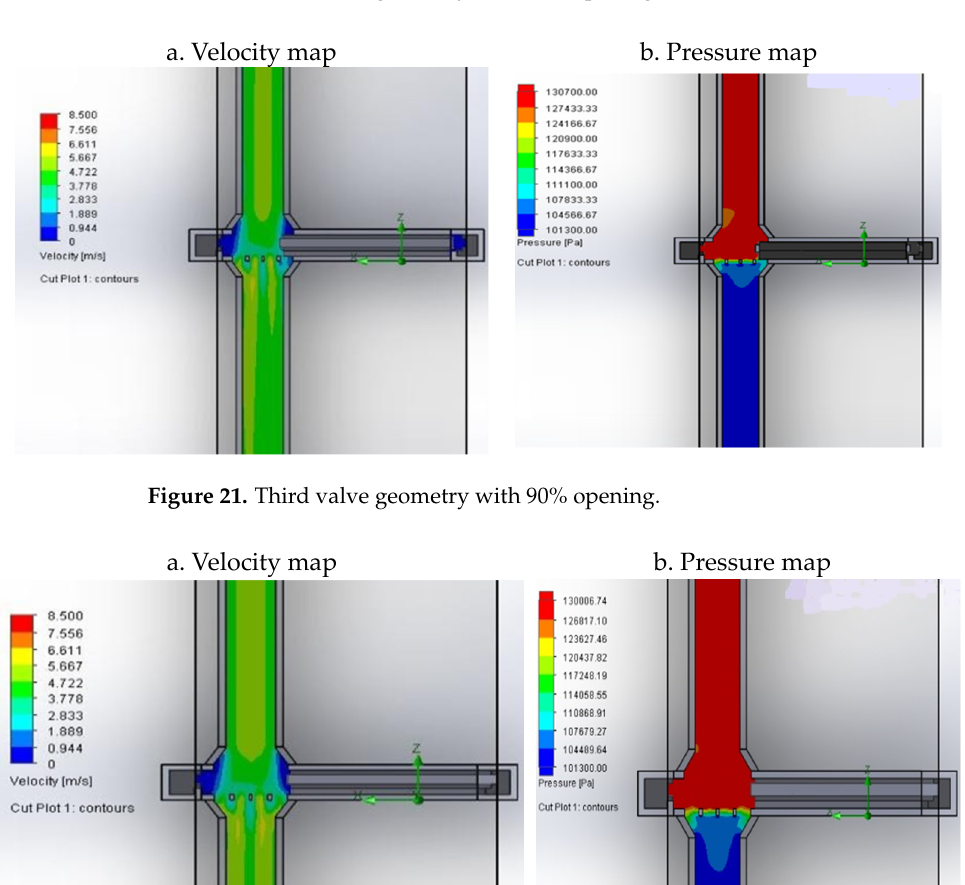
( c ) Figure 23. Changes in valve geometry. ( a ) First valve geometry; ( b ) second valve geometry; ( c ) third valve geometry. For the third geometry, the head loss was determined based on the results obtained from the fl ow simulation with the CFD software. Using Equation (7), a 2.90 pressure drop coe ffi cient of the valve when 100% open (Kv 100 ) was calculated. In comparison, the head loss coe ffi cient for a globe valve when 100% open is Kv 100 = 9.00 [33]. This indicates that the new valve possesses a great advantage over the globe valve when comparing their head loss coe ffi cients (Kv 100 ). Thus, the valve developed in this study presents a signi fi cant